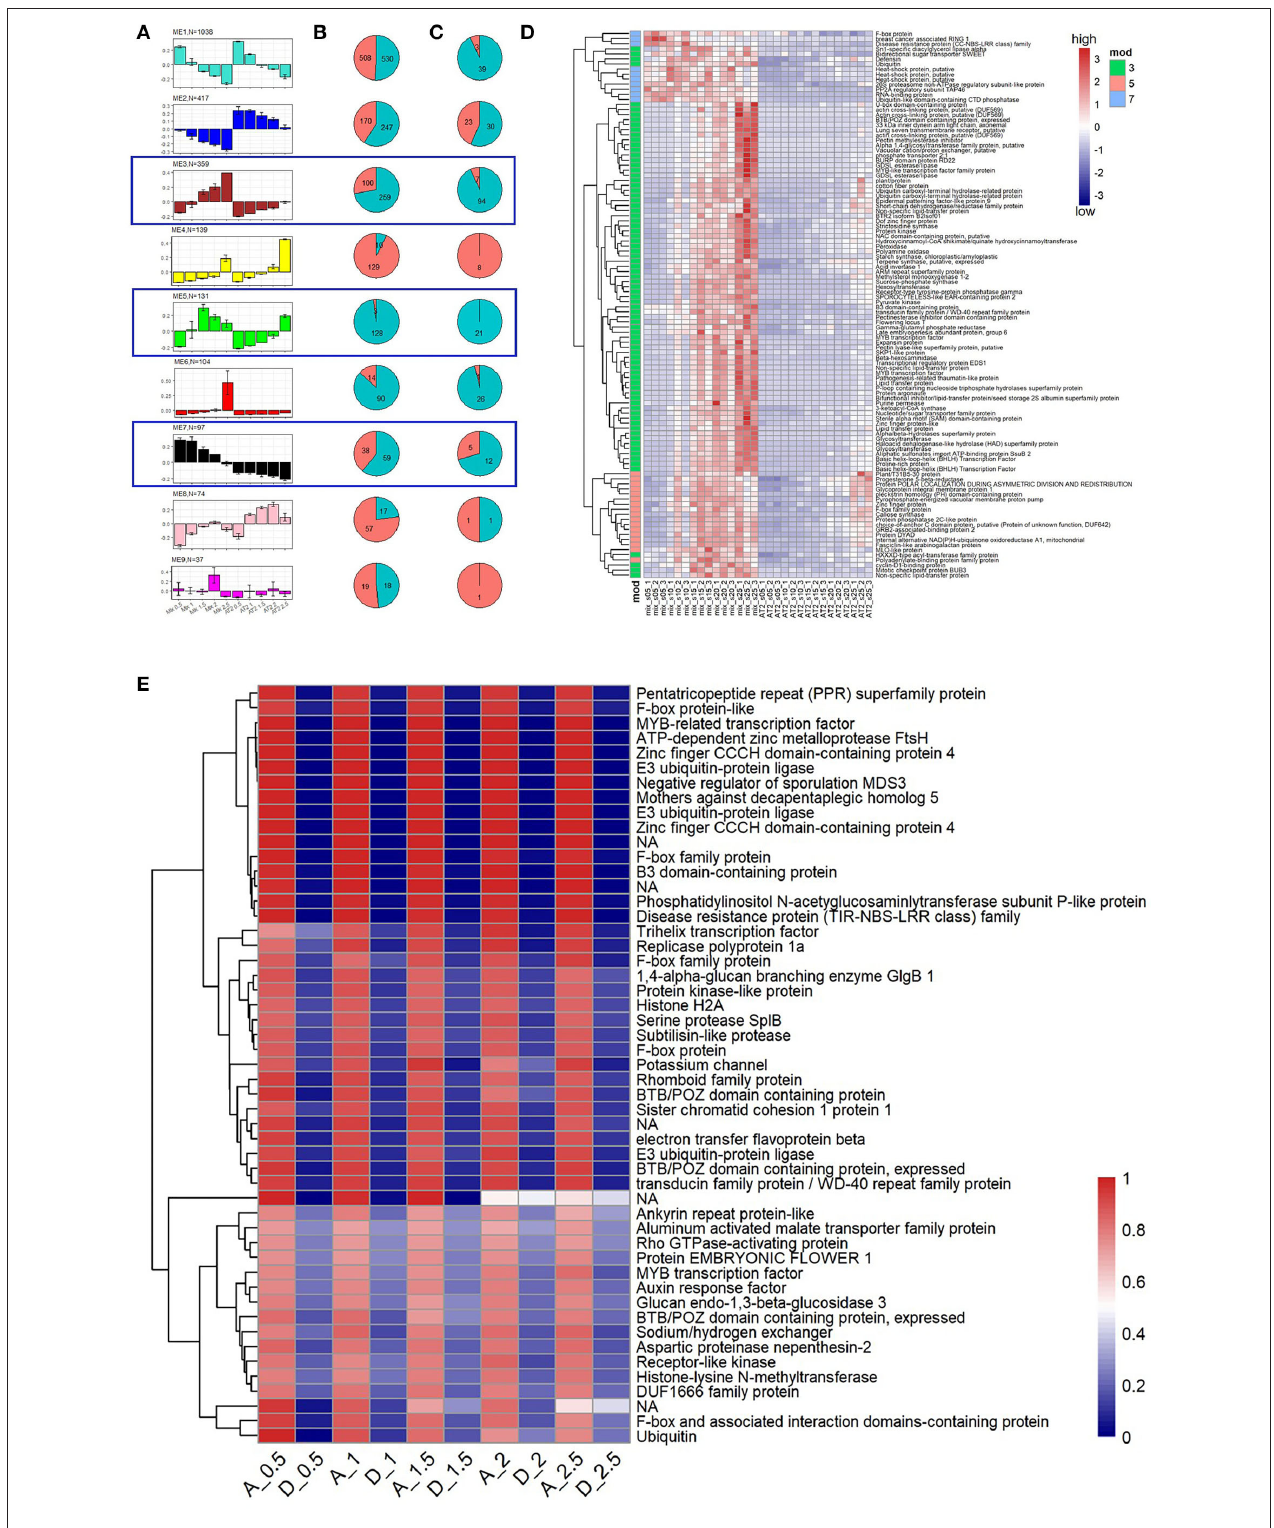
FIGURE 5 | Gene expression patterns during spike development in AT2 and parents. (A) SDRGs in modules of co-expression network. Bar plots present eigengene values centered by mean across developmental stages. Error bars represent the standard errors among three biological replicates for each spike